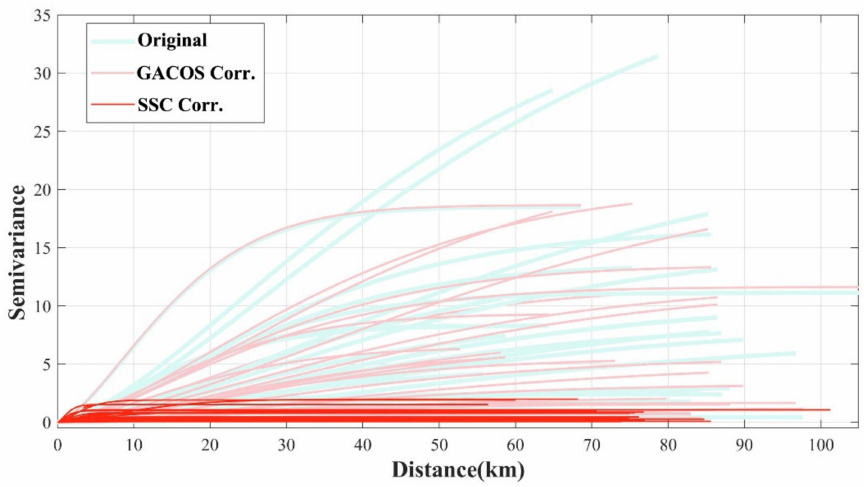
Figure 5. Semivariance of tested earthquake dataset before and after atmosphere